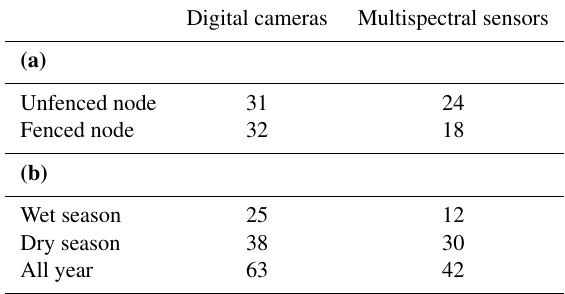
Table 3. Of the 33 days of field data collections, the number of days, (a) of field sampled data matching the filtered sensor data at each node, and (b) matching filtered data combined for both nodes from each of the wet and dry